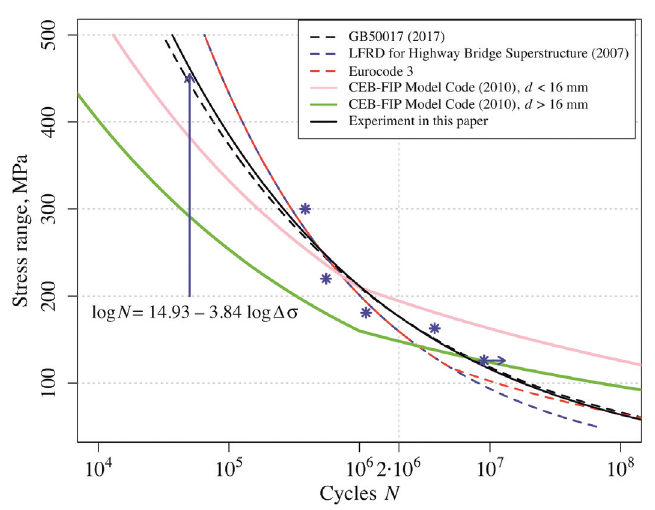
Figure 9. Experimental results and official steel and reinforcing bar S-N curves (the star symbol with a right arrow means an infinite